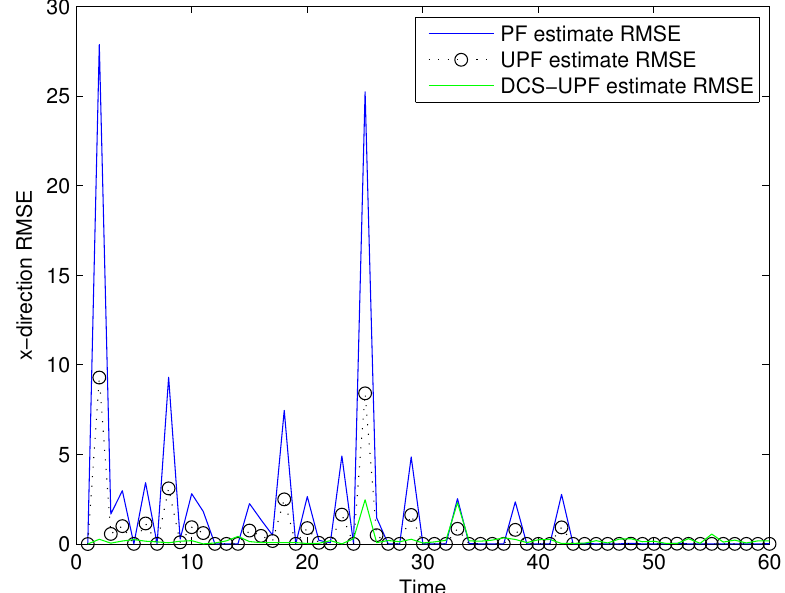
Figure 5. The tracking errors of three filters in X-direction.